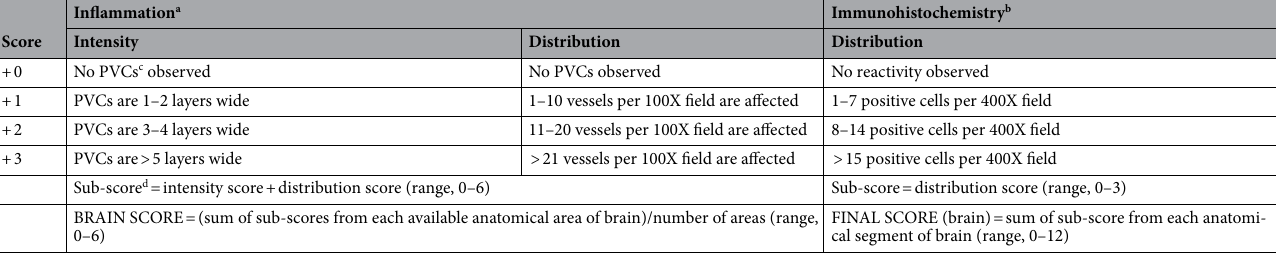
nal cord, proventriculus, kidneys, and gonads) were collected into sterile screw cap tubes containing 1.0 mL of preserving solution (20 mM ethylenediaminetetraacetic acid [EDTA], 25 mM sodium citrate, and 70% (w/v) ammonium sulfate with a pH of 5.2), and frozen at − 80 °C until RNA extraction. Total RNA was extracted from 300 mg of tissue or, for swabs, 300 μL of preserving solution using E.Z.N.A RNA Kit II (Omega Bio-Tek), fol- lowing the manufacturer’s protocol. Purified RNA was reverse transcribed and amplified using a Luna Universal Probe one-step RT-qPCR kit (NEB) with primers and probes targeting the ABBV-1 N gene (forward, 5 ′ -ATG